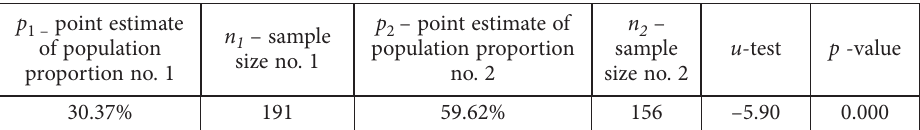
Table 5. Results of test about the difference between two population proportions (enterprises using controlling with dominance of domestic capital – no. 1 and foreign capital – no. 2) p 1 – point estimate of population proportion no.